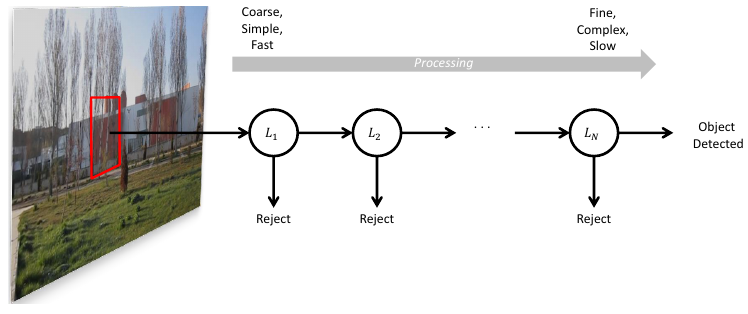
Figure 1. The stages of processing in a cascaded approach. At each stage, a decision to reject or to continue processing is made. If all stages pass, then the method declares detection of the